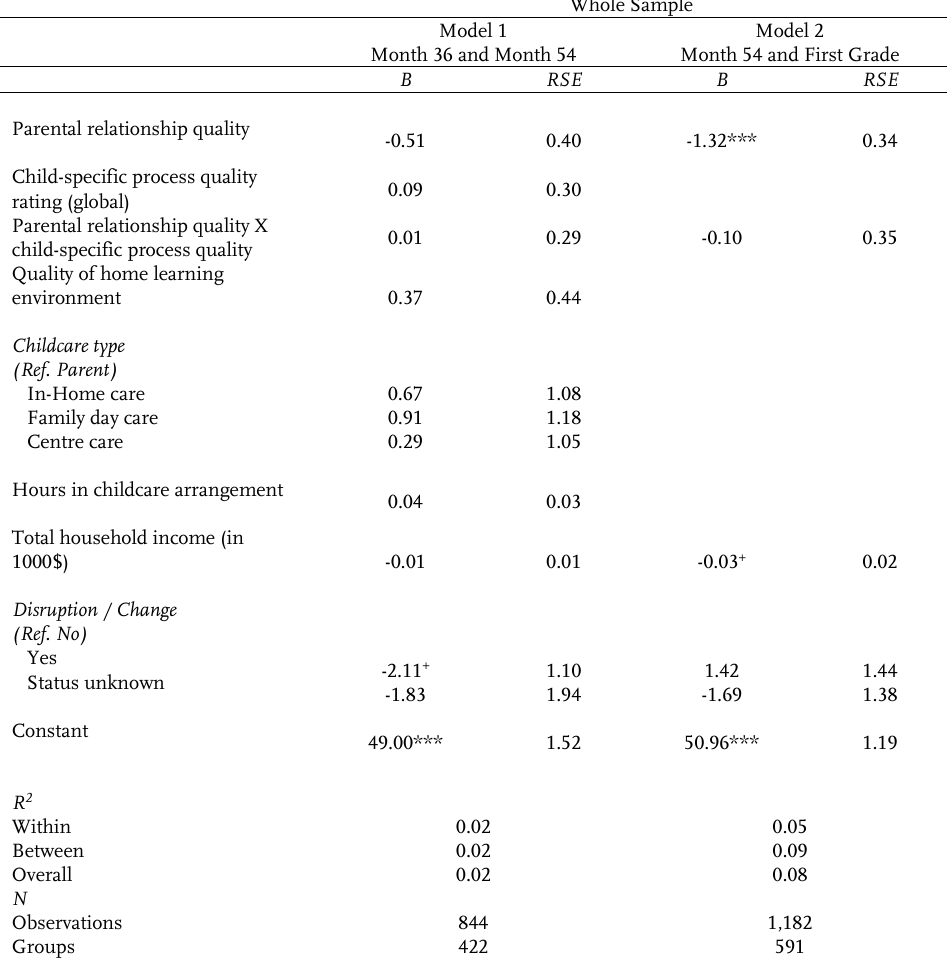
Table 3 : Fixed-effects models of child behavior checklist scores, month 36 through first grade, with child-specific process quality rating